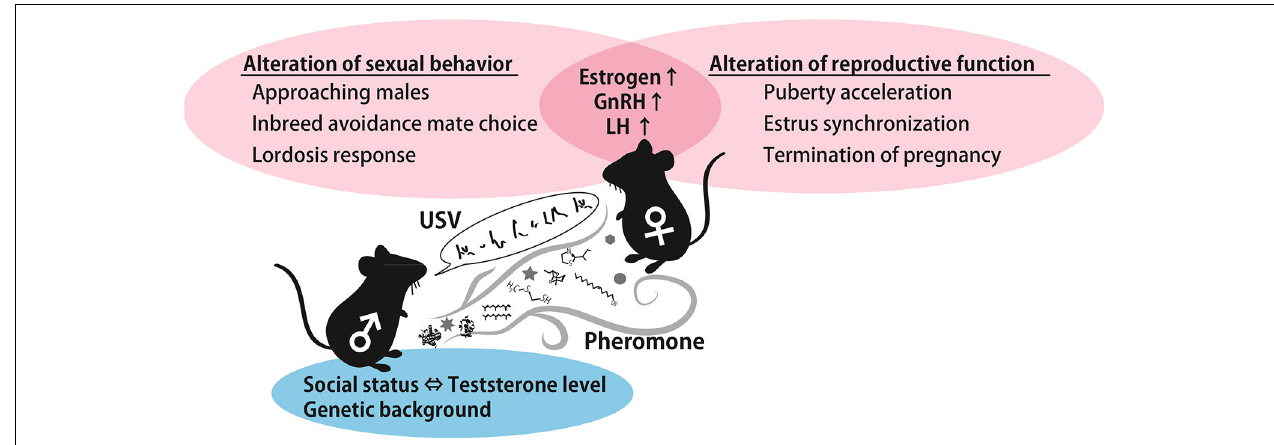
FIGURE 3 | A schematic illustration of the effect of male cues. Testosterone-controlled male pheromones alter female sexual behavior and reproductive function by increasing estrogen and GnRH. In addition, genetic